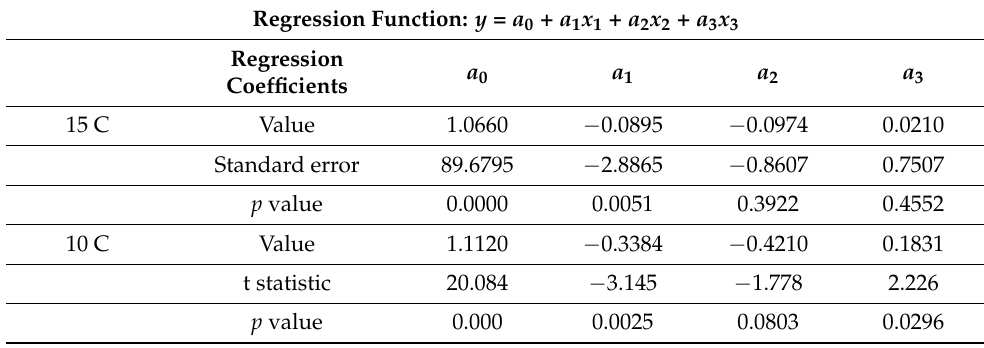
Table A2. The regression value of different coefficients (characteristic frequency